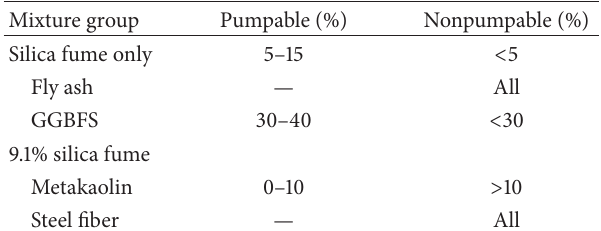
Table 2: Recommended replacement/addition ranges for each